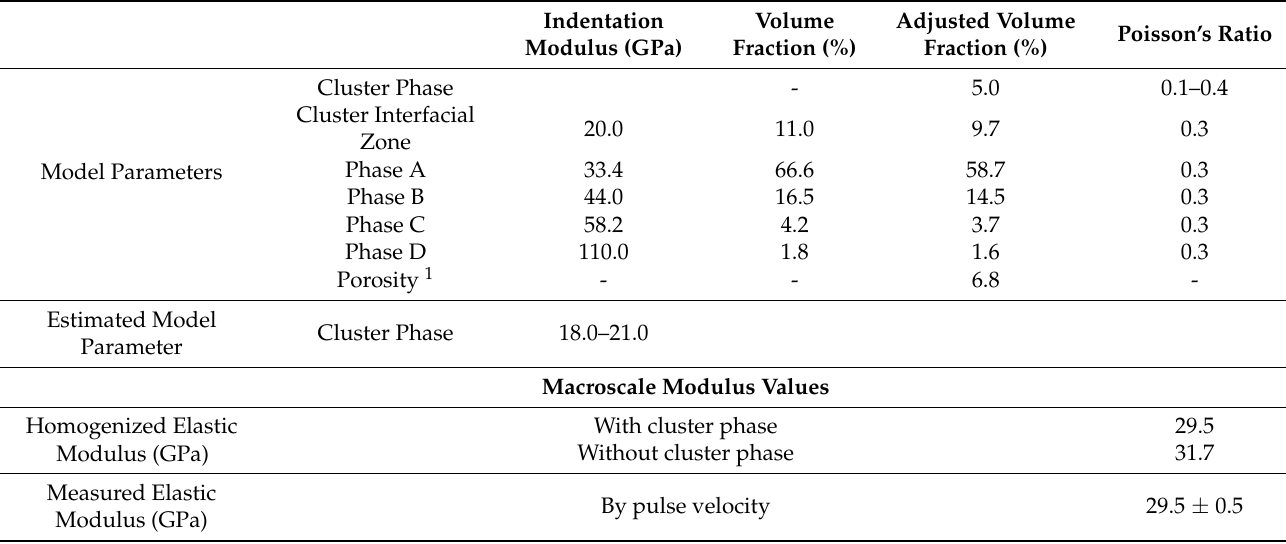
Table 4. Input parameters from grid nanoindentation data plus a phase for the CNF clusters and calculated overall homogenized elastic modulus of the cement paste with CNFs from the microscale– macroscale analytical homogenization